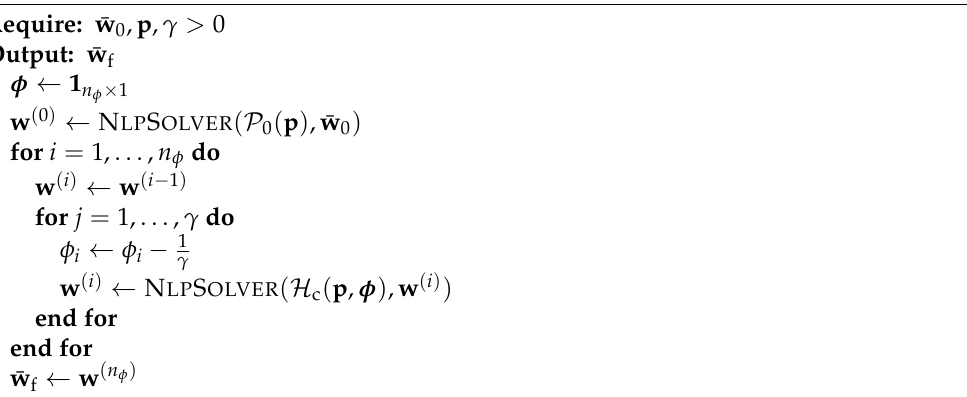
Algorithm 1 Classic Interior-Point-based Homotopy